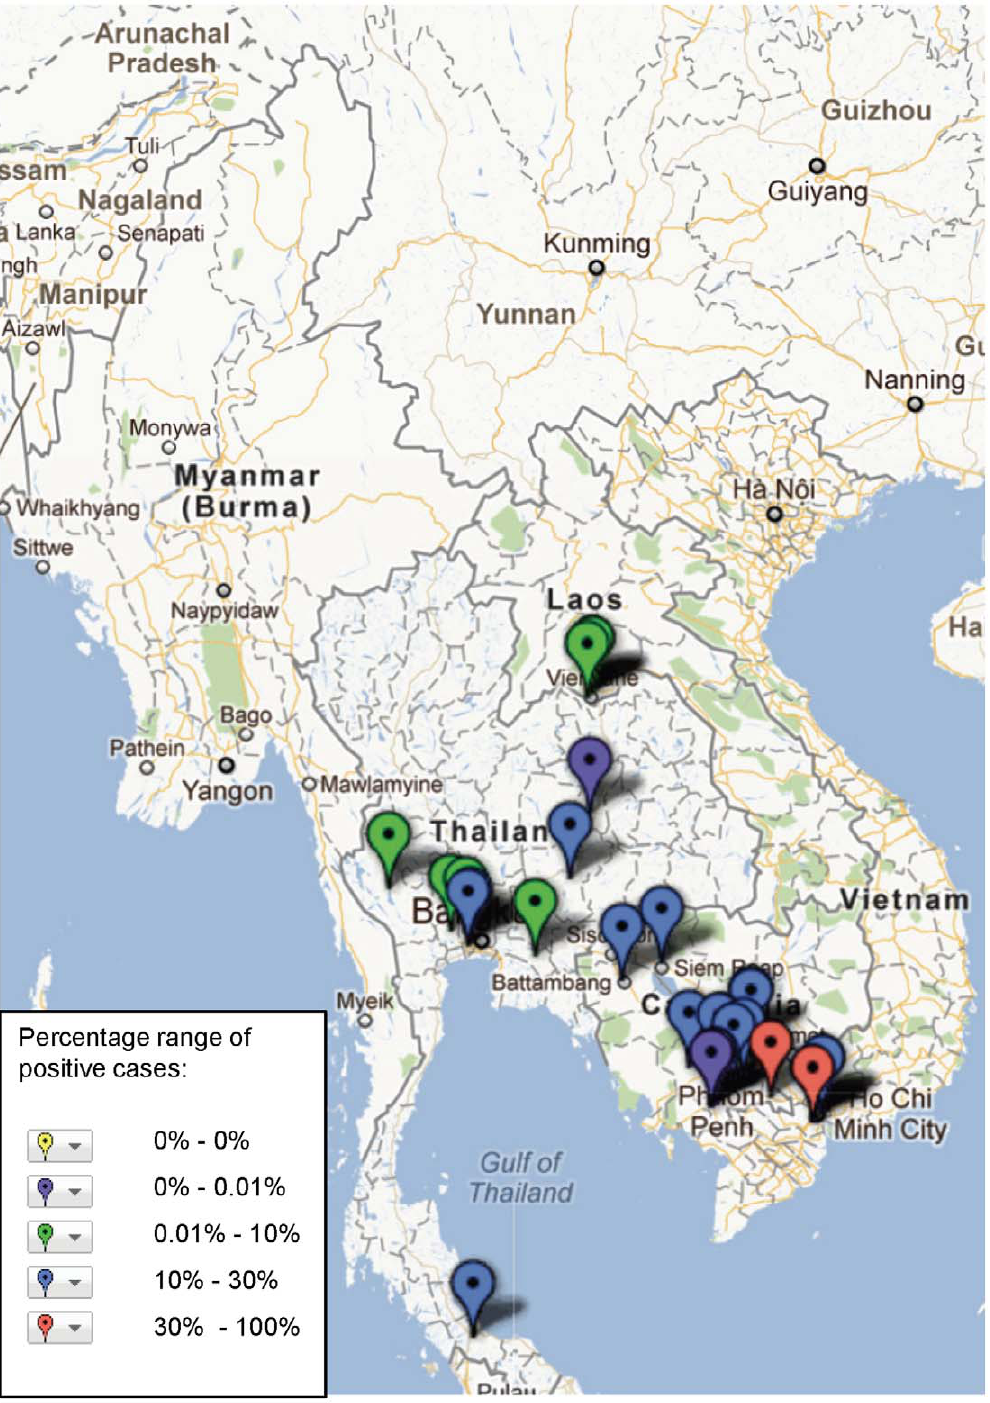
Figure 9. Study sites in the Mekong region where Japanese encephalitis virus has been reported, illustrating frequency of identification (case) based on assays and sample population used in the study (see Table S1).